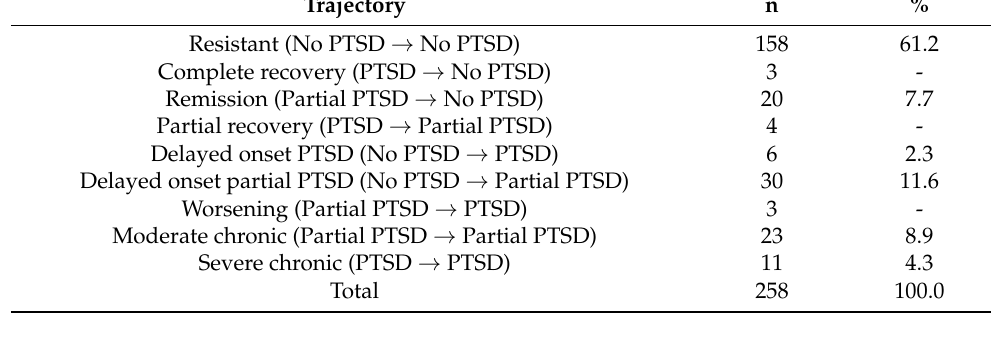
Table 2. Prevalence of trajectories of PTSD between wave 1 and wave 2, n=258.